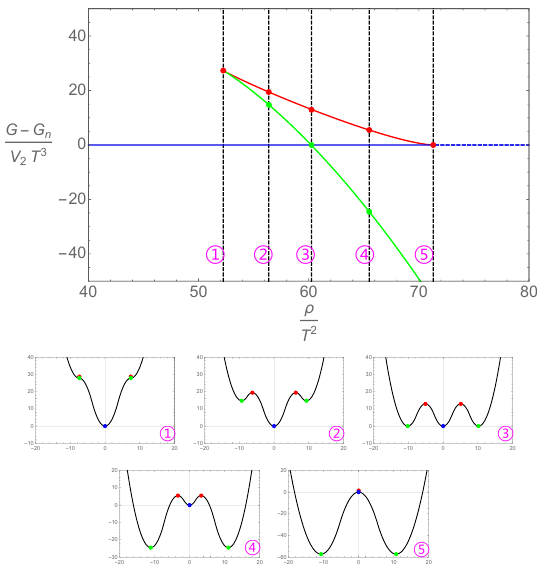
Figure 7 . The potential landscape the 1st order phase transitions. The shapes of the potential indicated with ‹ – (cid:176) relate to the corresponding points in the top panel. Same colors are also